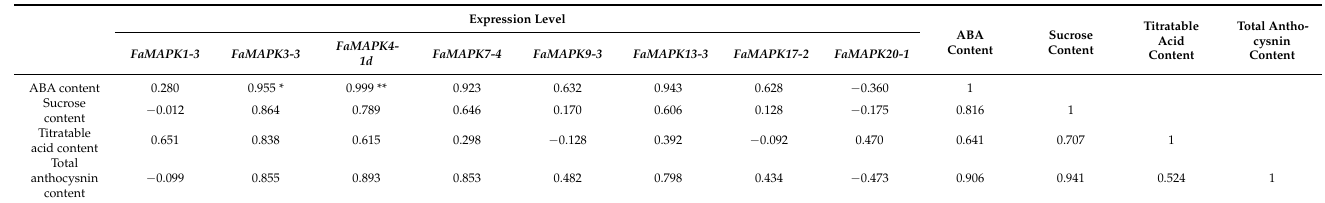
Table 2. Correlation coefficient between relative expression level of FaMAPK genes with ABA, sucrose, titratable acid and total anthocyanin content under exogenous sucrose and abscisic acid treatments. ExpressionLevel